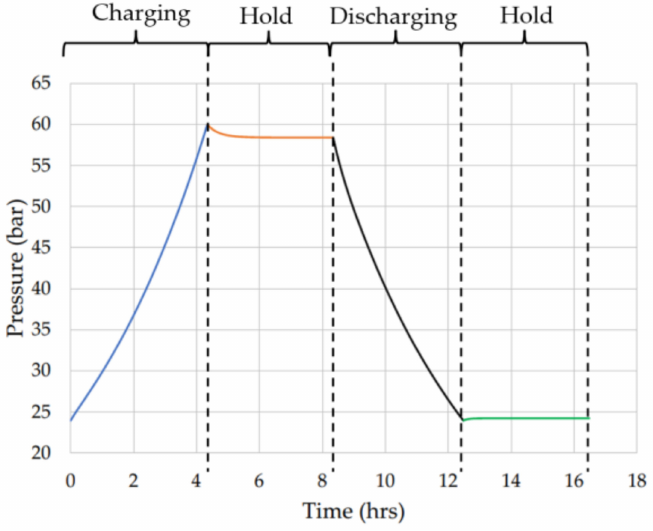
Figure 2. Pressure (bar) against Time (hrs) for a subsea accumulator exhibiting the four stages under